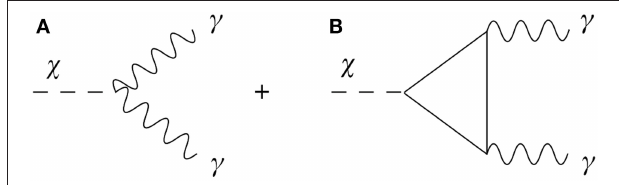
γγ decay. describing the anomaly →